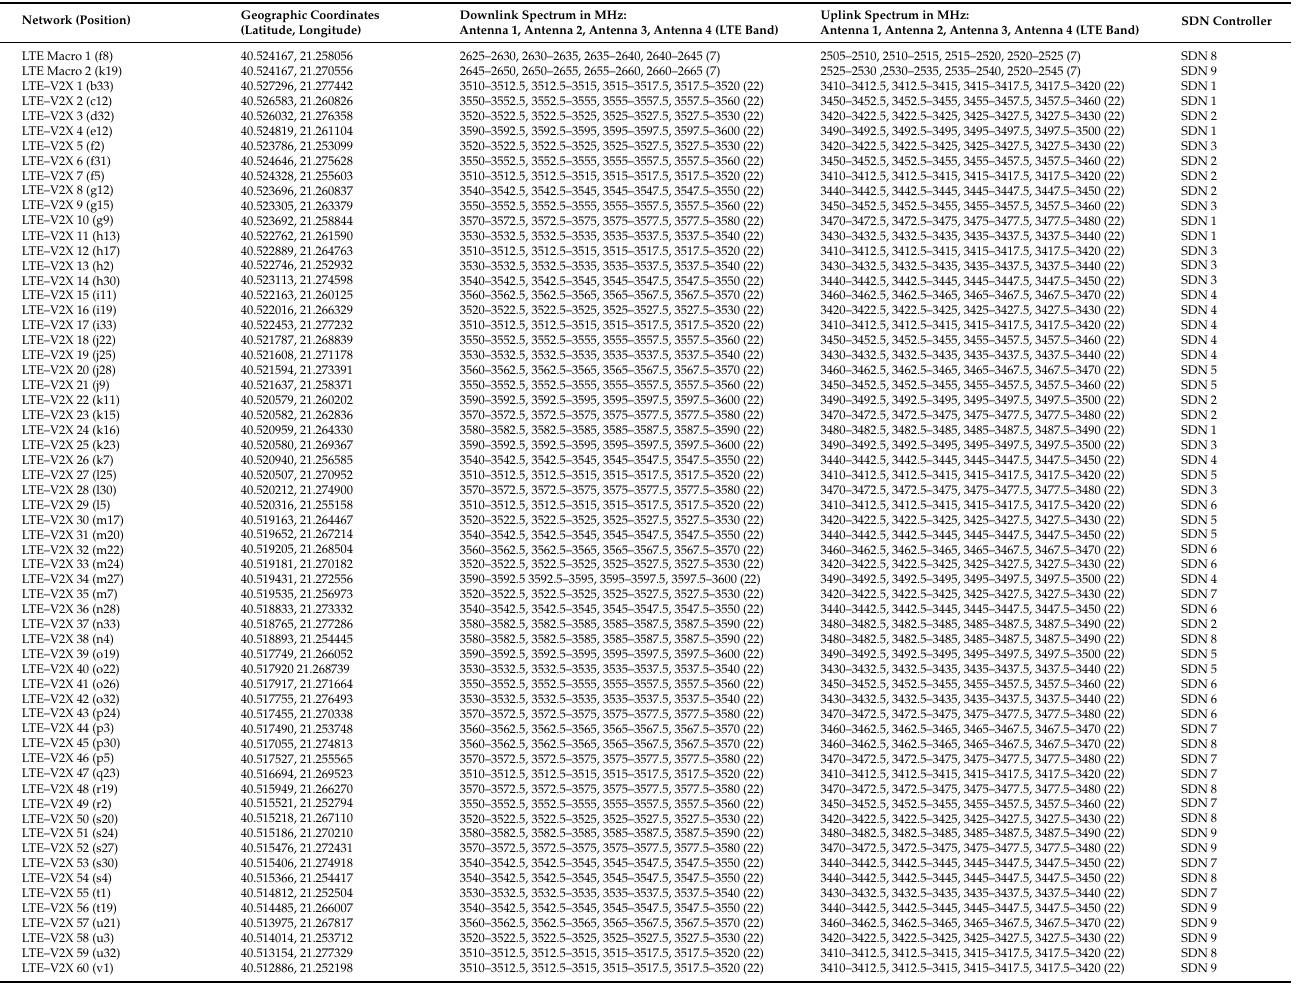
Table A2. The positions and the frequencies of the available LTE–A Macrocells and LTE V2X RSUs.